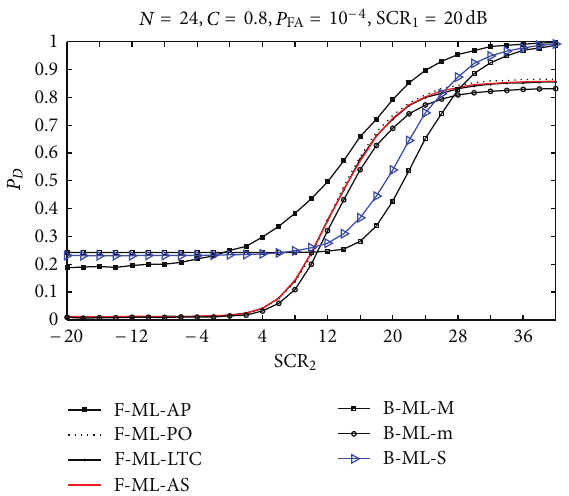
performance of distributed detector 2